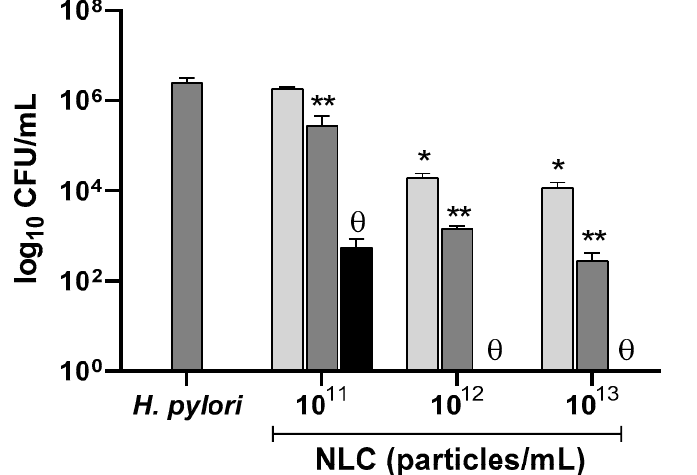
Figure 10. Antibacterial performance of increasing concentrations of NLC60 M pre-immersed in PBS, medium (MHB) and medium with FBS (MHB + 10% FBS) against H. pylori J99 (6 h in PBS). Data are expressed as means ± standard deviation. Statistical analysis was performed against the control (bacteria without NLCs) using Tukey’s multiple comparisons test. * NLCs incubated in MHB + 10% FBS ( p < 0.01); ** NLCs incubated in MHB ( p < 0.0001) and θ NLCs incubated in PBS ( p < 0.0001).